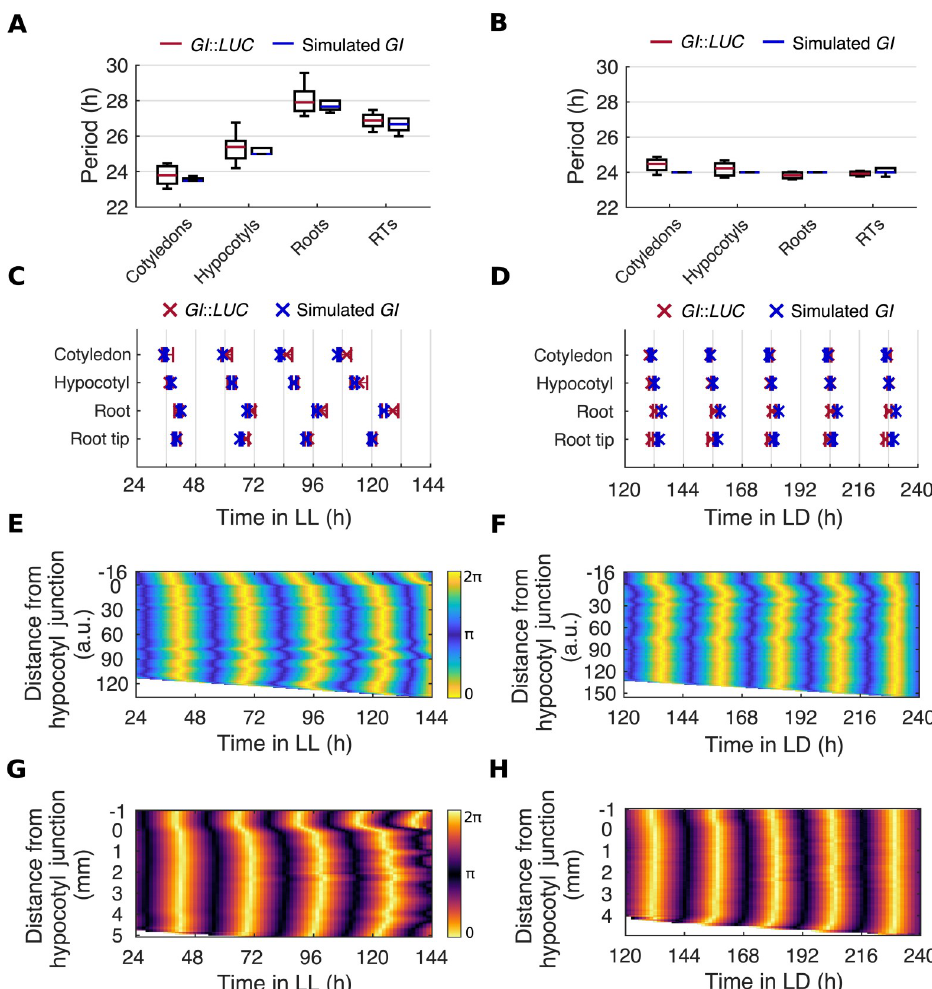
Fig 4. Period differences and local coupling can explain spatial waves of clock gene expression. (A, B) Period estimates of GI :: LUC and simulated GI for different organs imaged under LD-to-LL (A) and LD-to-LD (B) conditions. Box plots indicate the median and upper and lower quartiles, and whiskers the 9th and 91st percentiles of organs scored as rhythmic. (C, D) Times of peaks of expression of GI :: LUC and simulated GI in different organs under LD-to- LL (C) or LD-to-LD (D) conditions. Plots represent the 25th percentile, median, and the 75th percentile for the peak times of the oscillations of organs scored as rhythmic. (E, F) Representative phase plot of simulated GI expression across longitudinal sections of the hypocotyl and root of a single seedling under LD-to-LL (E) or LD-to-LD (F) conditions. Color maps are as in E. (G, H). Representative phase plot of GI :: LUC expression across longitudinal sections of the hypocotyl and root of a single seedling under LD-to-LL (G) and LD-to-LD (H) conditions. Color maps are as in G. For experimental data, N and n are as in Fig 2. For GI simulations, n = 24. N represents the number of independent experiments and n the total number of organs tracked. See S1 and S2 Files for exact n , test statistics, and percentage rhythmicity of each organ. Underlying data are available from https://gitlab.com/slcu/teamJL/greenwood_ etal_2019. GI , GIGANTEA ; LD, light-dark; LL, constant light; LUC , LUCIFERASE ; RT, root